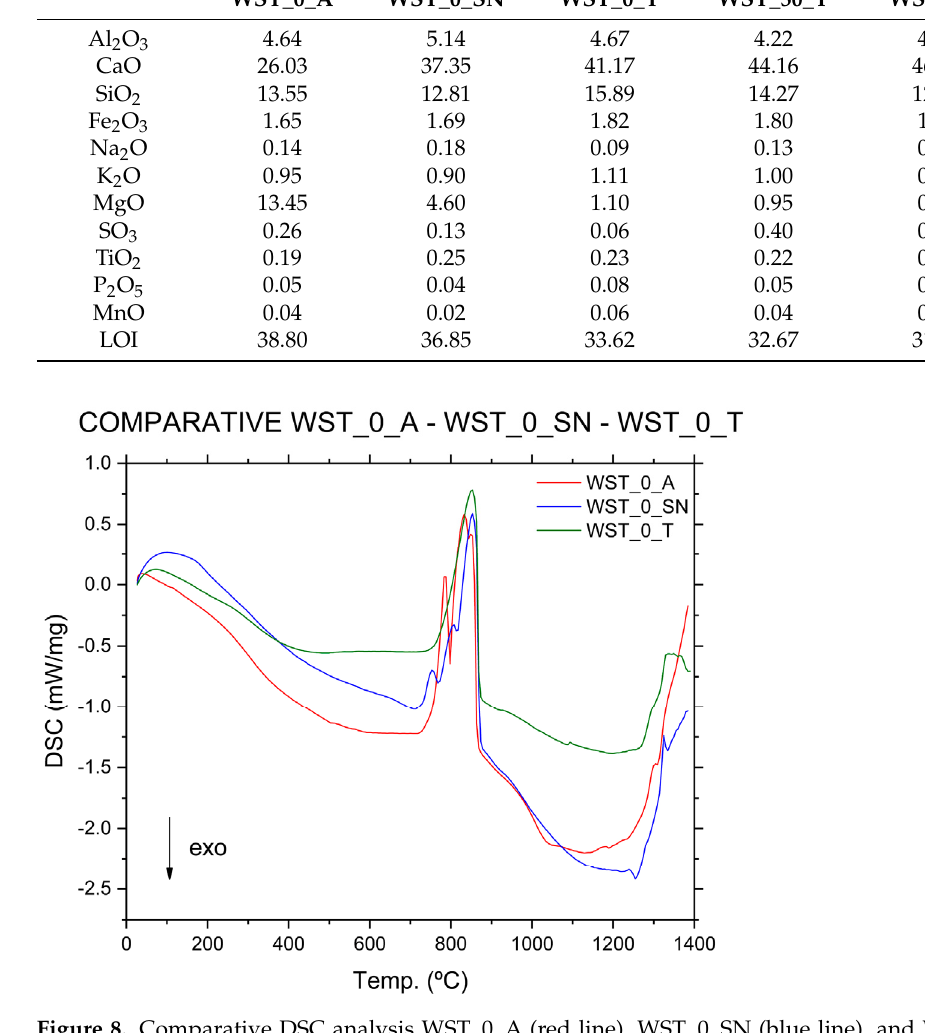
Figure 8. Comparative DSC analysis WST_0_A (red line), WST_0_SN (blue line), and WST_0_T (green line).